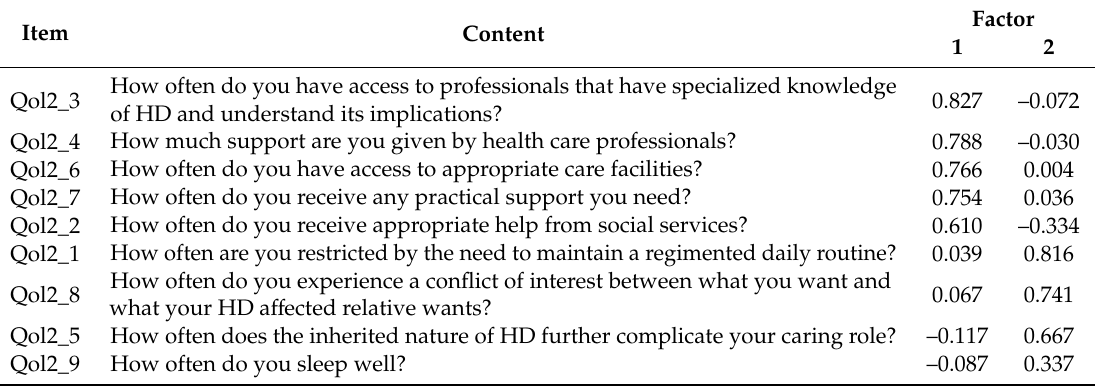
Table 2. Pattern Matrix of rotated factor loadings for section 2.